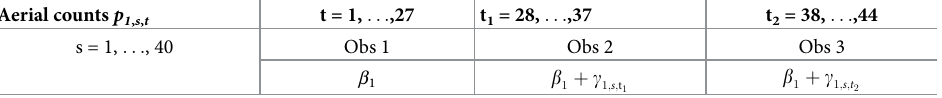
Table 1. Parametrization of the linear predictor of the conditional detection probability for aerial counts. Aerial counts p 1 , s , t t = 1, ... ,27 t 1 = 28, ... ,37 t 2 = 38, ... ,44 s = 1, ... , 40 Obs 1 Obs 2 Obs 3 b þ g þ g β 1 b 1 1 ; s ; t 2 1 1 ; s ; t 1 Index s corresponds to sites and index t to years . Three values of parameters were estimated for aerial counts (one for β and two for γ